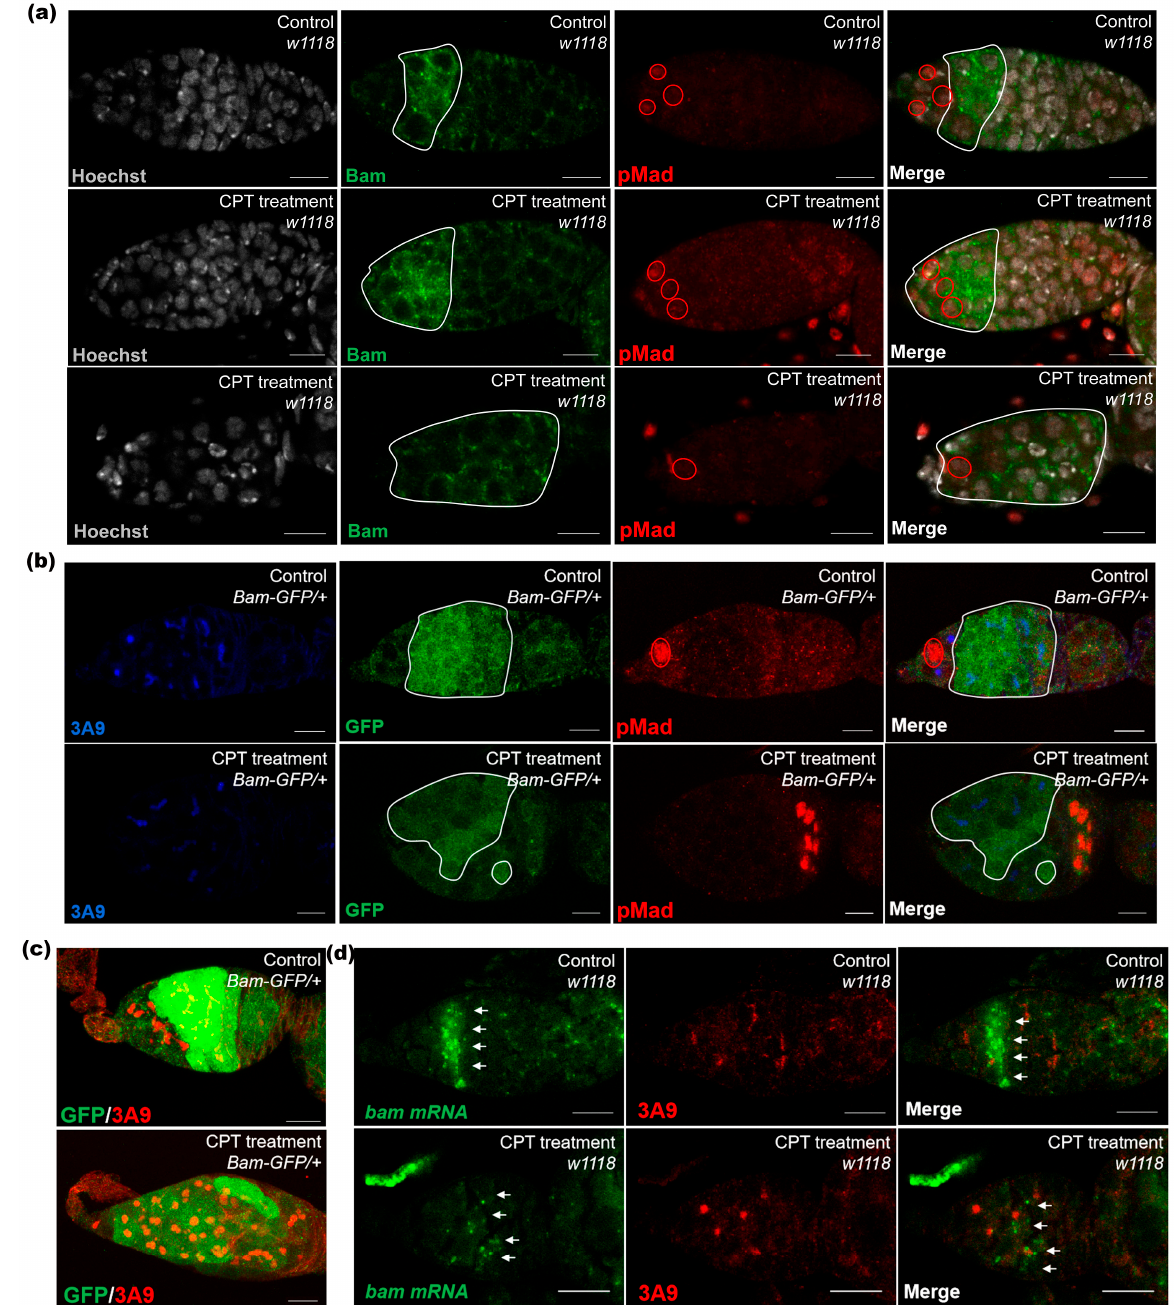
Figure 3. CPT could influence differentiation process by regulating Bam expression. ( a ) Control and CPT-treated germaria were labeled with Hoechst (white), anti-Bam (green) and anti-pMad (red) to examine Bam expression. White dashed circle indicated the location of Bam in control and CPT-treated germarium. ( b ) Germaria of female flies expressed GFP under the control of transcriptional of Bam stained with GFP (green), anti-3A9 (blue), and pMad (red). ( c ) Germaria of female flies expressed GFP under the control of transcriptional of Bam stained with GFP (green) and anti-3A9 (red). ( d ) In situ hybridization to examine bam expression at mRNA level with anti-3A9 (red) labeling with or without CPT treatment, white arrows indicated bam mRNA signal. Scale bar, 10 μ m.